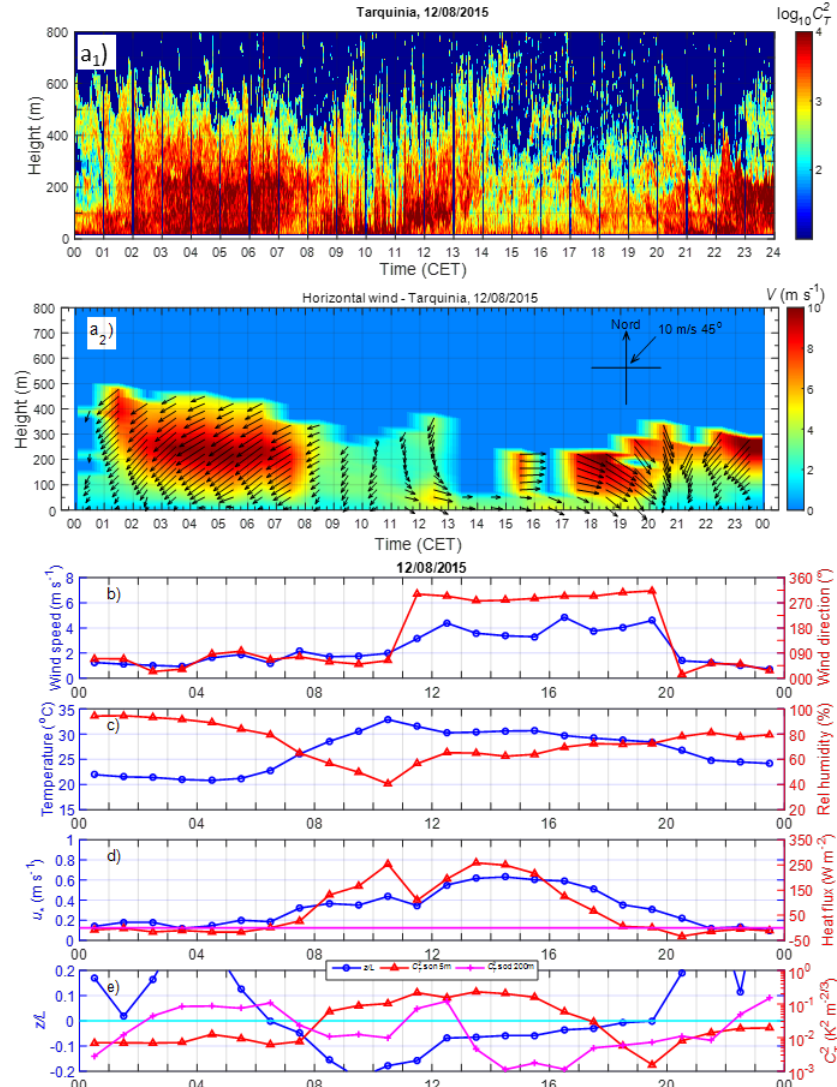
Figure 16. Example of the diurnal variation of the ( a 1 ) ABL thermal turbulence and ( a 2 ) wind field structures; ( b ) wind speed and direction at 5 m; ( c ) temperature and relative humidity; ( d ) friction velocity and sensible heat flux; and ( e ) the stability parameter z / L at 5 m and the temperature structure parameter C T 2 at 5 m (from the sonic anemometer) and at 200 m (from the sodar in arbitrary units) on 12 August 2015. (3) In Figure 17, a daily pattern showing the presence of a convective boundary layer over the entire 24 h period is presented.